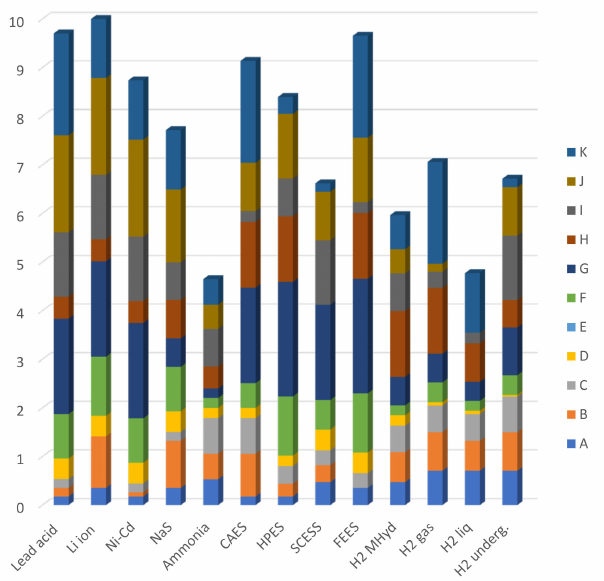
Figure 8. Performance of storage solutions per KPIs—Scenario A-2030. A–K are the KPIs. (A) Mass energy density, (B) Energy content per footprint, (C) Discharge duration, (D) Response time, (E) Capacity, (F) Efficiency, (G) Safety, (H) Environmental impact, (I) Maintenance, (J) Integrability and (K)